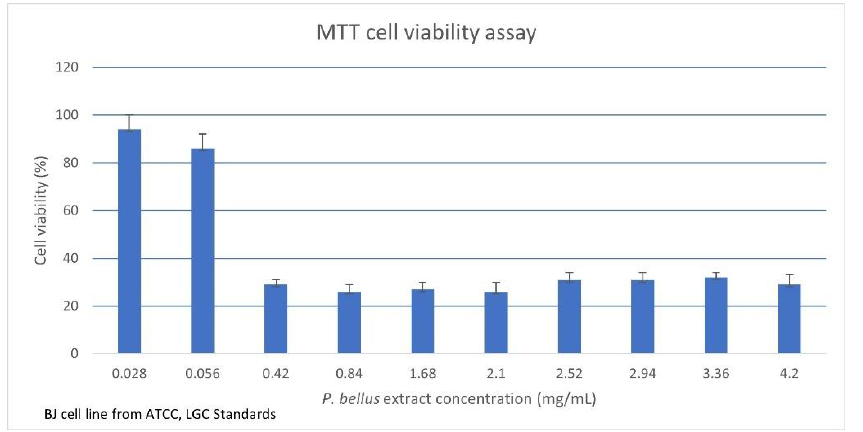
Figure 4. The MTT cell viability assay on a human skin fibroblast cell line. The results are expressed as cell viability with different P. bellus extract concentrations. Values are given as mean + standard error.